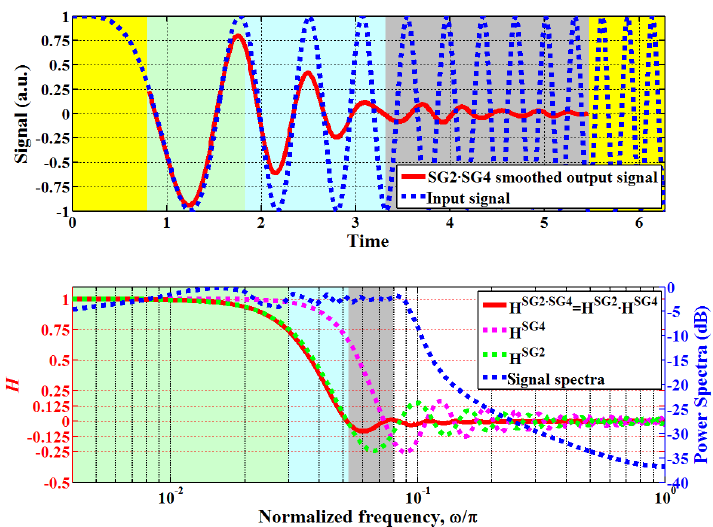
Figure B1. Upper plot: the chirp signal (blue dashed line) is smoothed by SG2 and an SG4 in cascade (red line), both with the same N = 33. A comparison in time domain with Fig. 2 evidenced the larger transient region (in yellow) with respect to the “single” SG2, N = 33.The cascaded filter frequency response (bottom plot) exhibits a pass band similar to the SG2 but with reduced side lobes. This latter feature virtually eliminates high-frequency artifacts in the smoothed signal in upper panel. Color code like Fig. 2, H ≈ 1 for 0 <ω/π< 4 × 10 − 3 .